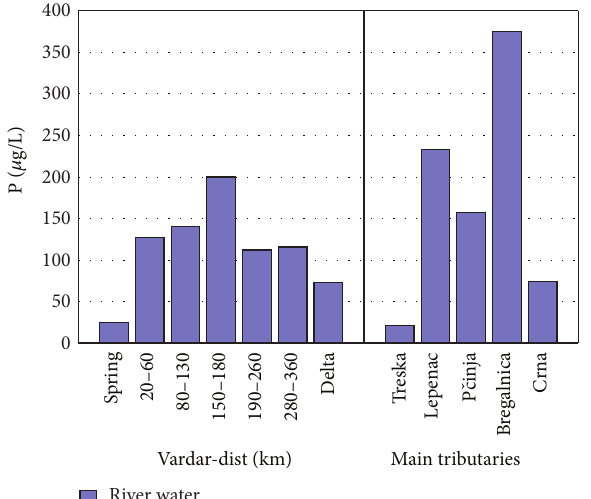
Figure 8: Factor 3 (factor scores) of river Vardar and main